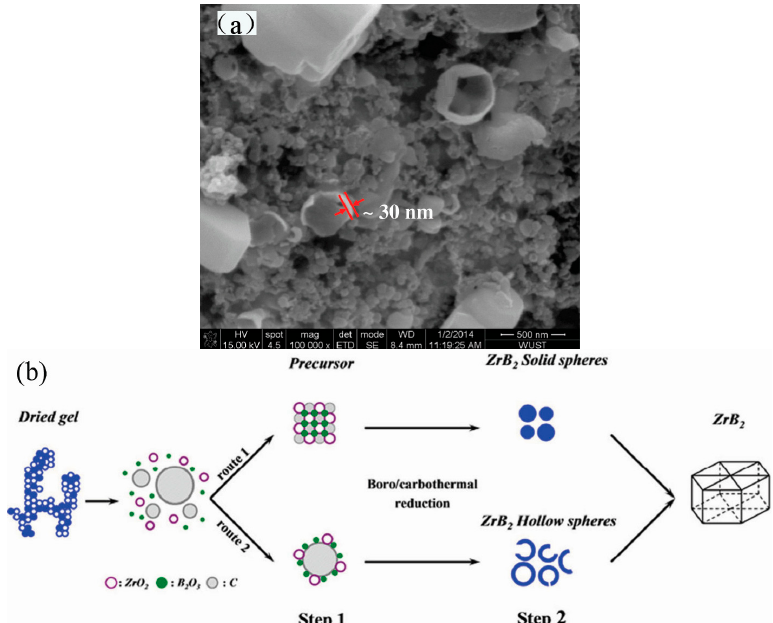
Figure 1. ( a ) SEM image of ZrB 2 prepared at 1500 °C for 2 h; ( b ) Schematic illustration of the grown process of hollow ZrB 2 spheres crystals [65].